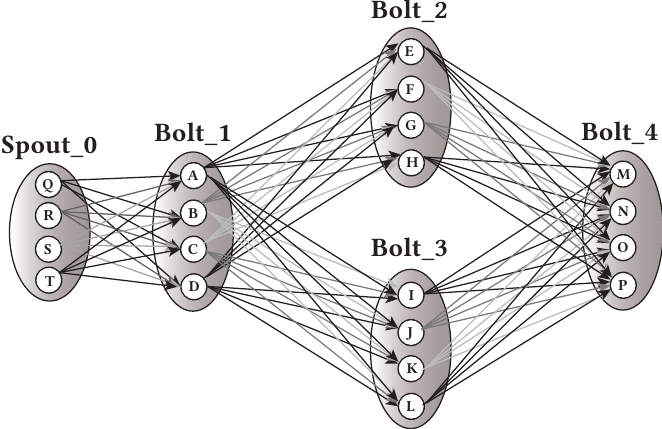
Figure 1. Task interconnection for a random